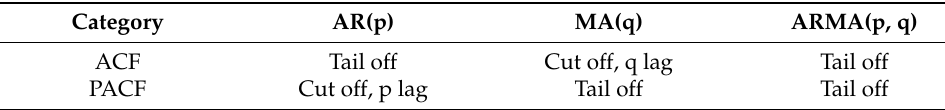
Table 1. Method of finding the order of the ARIMA